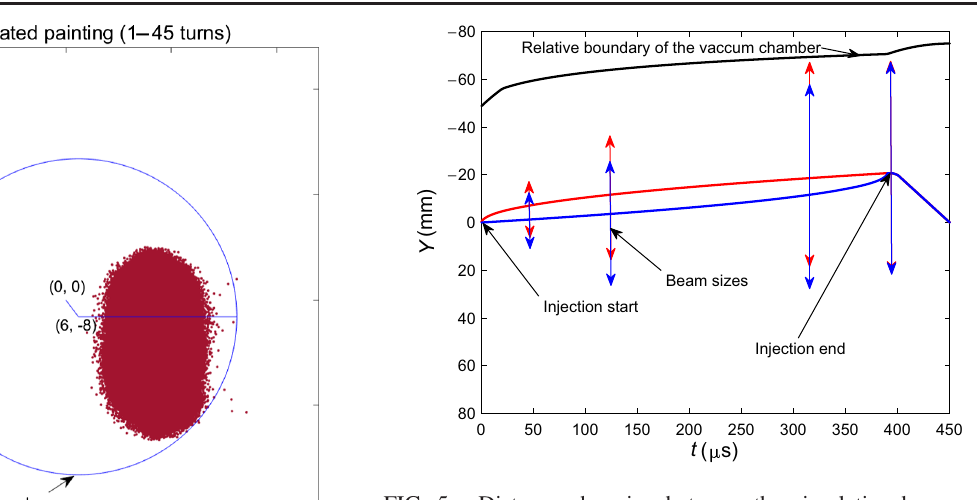
FIG. 5. Distance changing between the circulating beam and vacuum chamber for different vertical painting curves. Since the vertical painting bump is in the negative direction, the pulse current and bump position differ by a negative sign. Therefore, the Y -axis is rotated 180° to avoid misunderstanding.